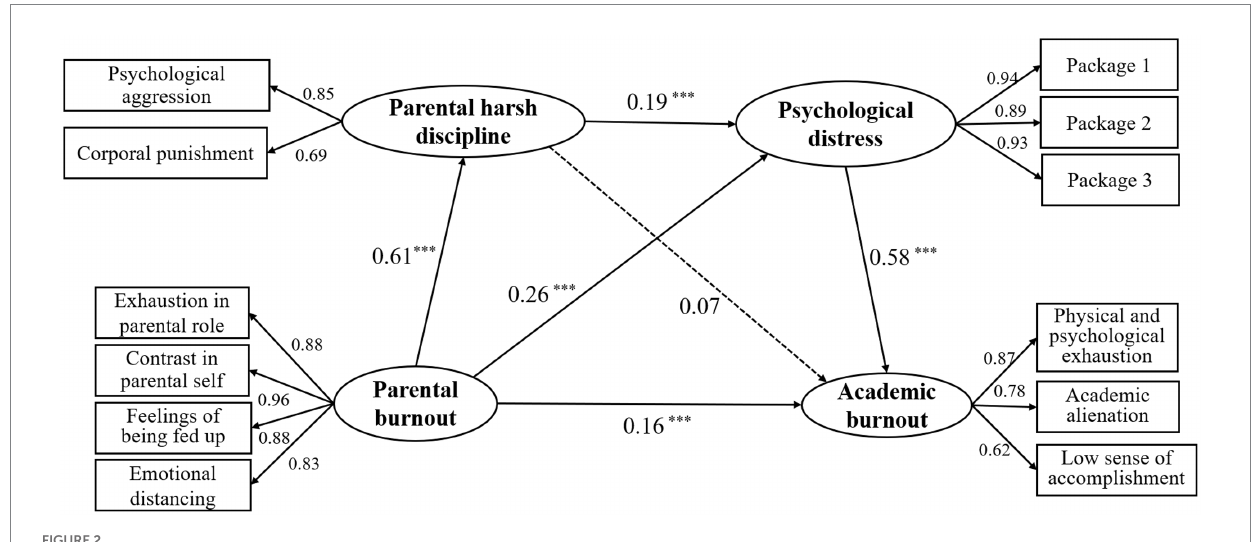
FIGURE 2 The multiple mediation model. All path coefficients were standardized. * p < 0.05, ** p < 0.01, *** p <